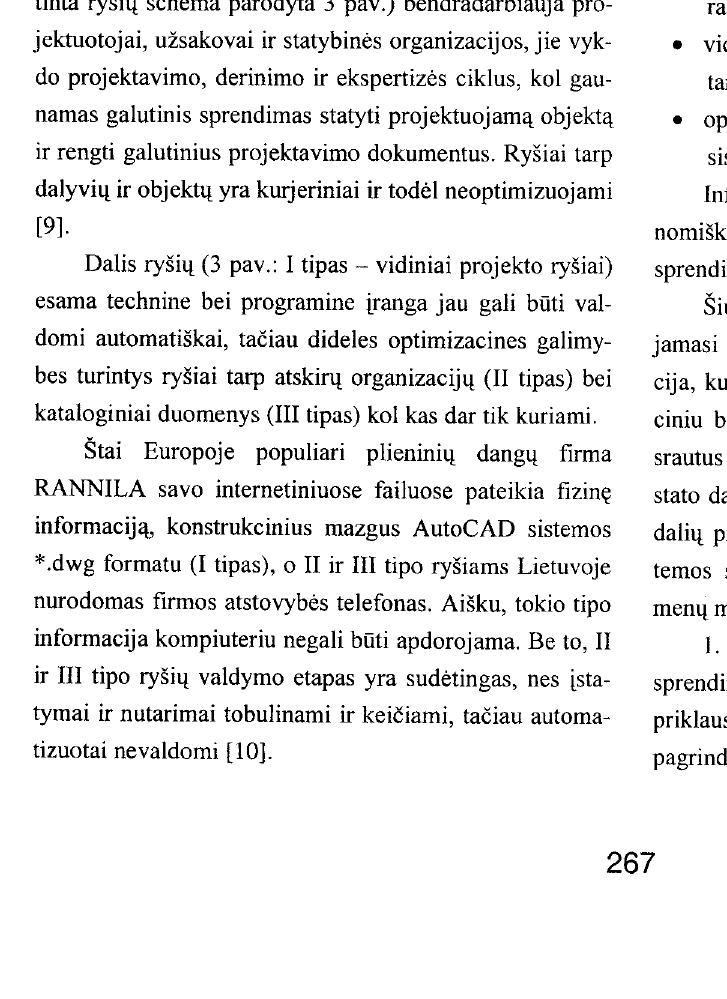
Fig 3. Scheme of traditional design managing